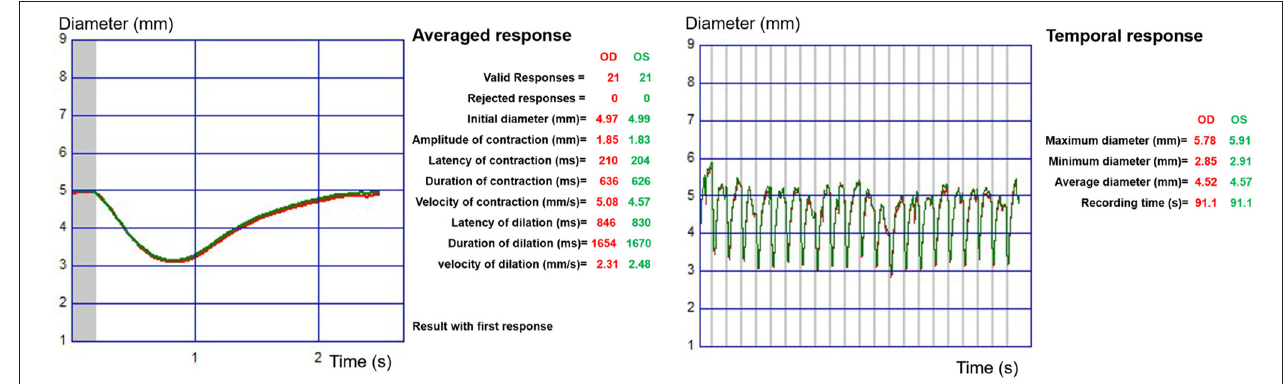
FIGURE 1 | Dynamic pupillometry output data determined via the automatic quantitative pupillary vision monitor system (MonPack One, Metrovision, France). At the left, an averaged response is shown, and at the right, a temporal response is